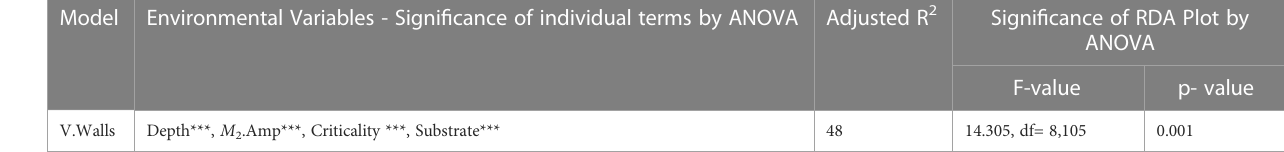
TABLE 6 Results from Canonical Redundancy Analysis of Hellinger transformed species data and selected environmental